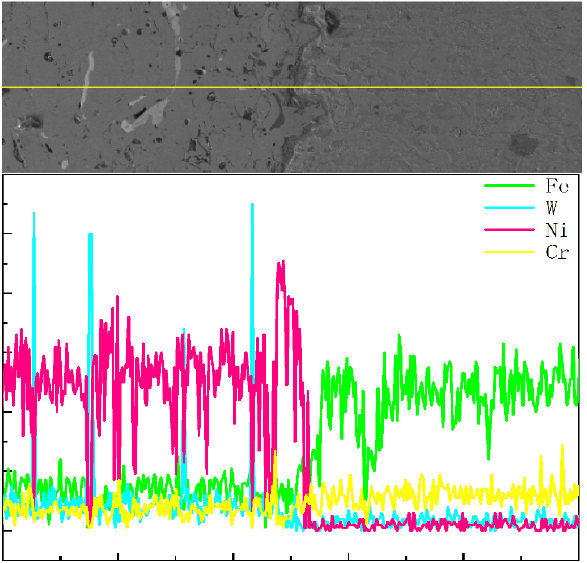
Figure 5. Line scanning results of HT + UDR + 0.25 mm coating interface.